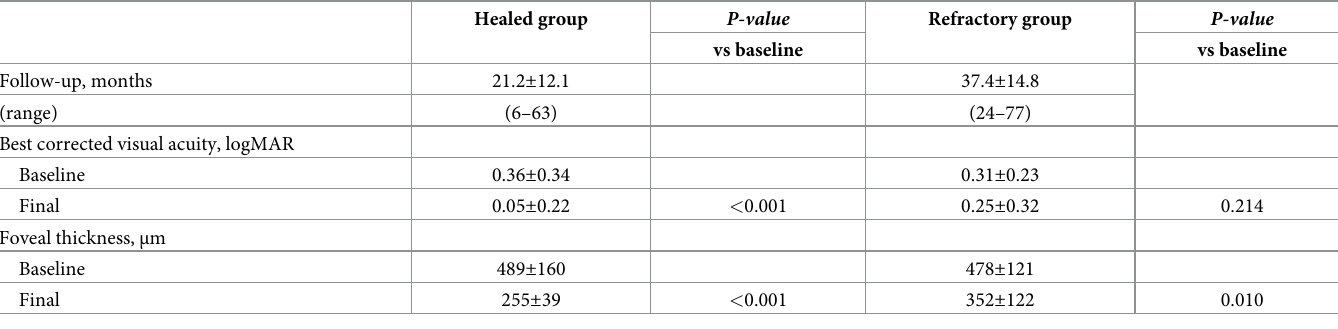
Table 2. Changes in best corrected visual acuity and foveal thickness at final examination. Healed group P-value Refractory group P-value